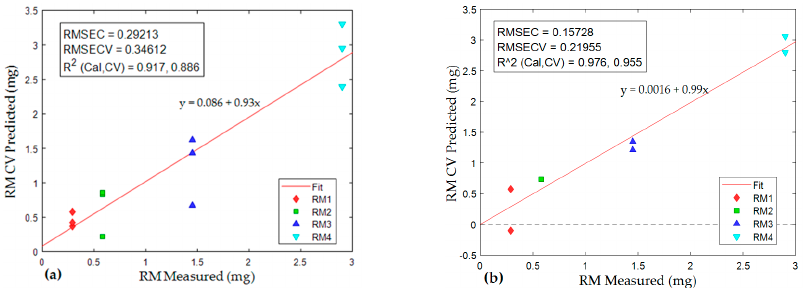
Figure 10. Partial least squares (PLS) linear regression of score values of samples in TGIS and TGO against measured values of RM. ( a ) Regression of TGIS samples, ( b ) regression of TGO samples. X-axis represents measured RM, Y-axis represents predicted RM. In the regression equation, y = predicted rubber materials (RM), x = measured rubber materials